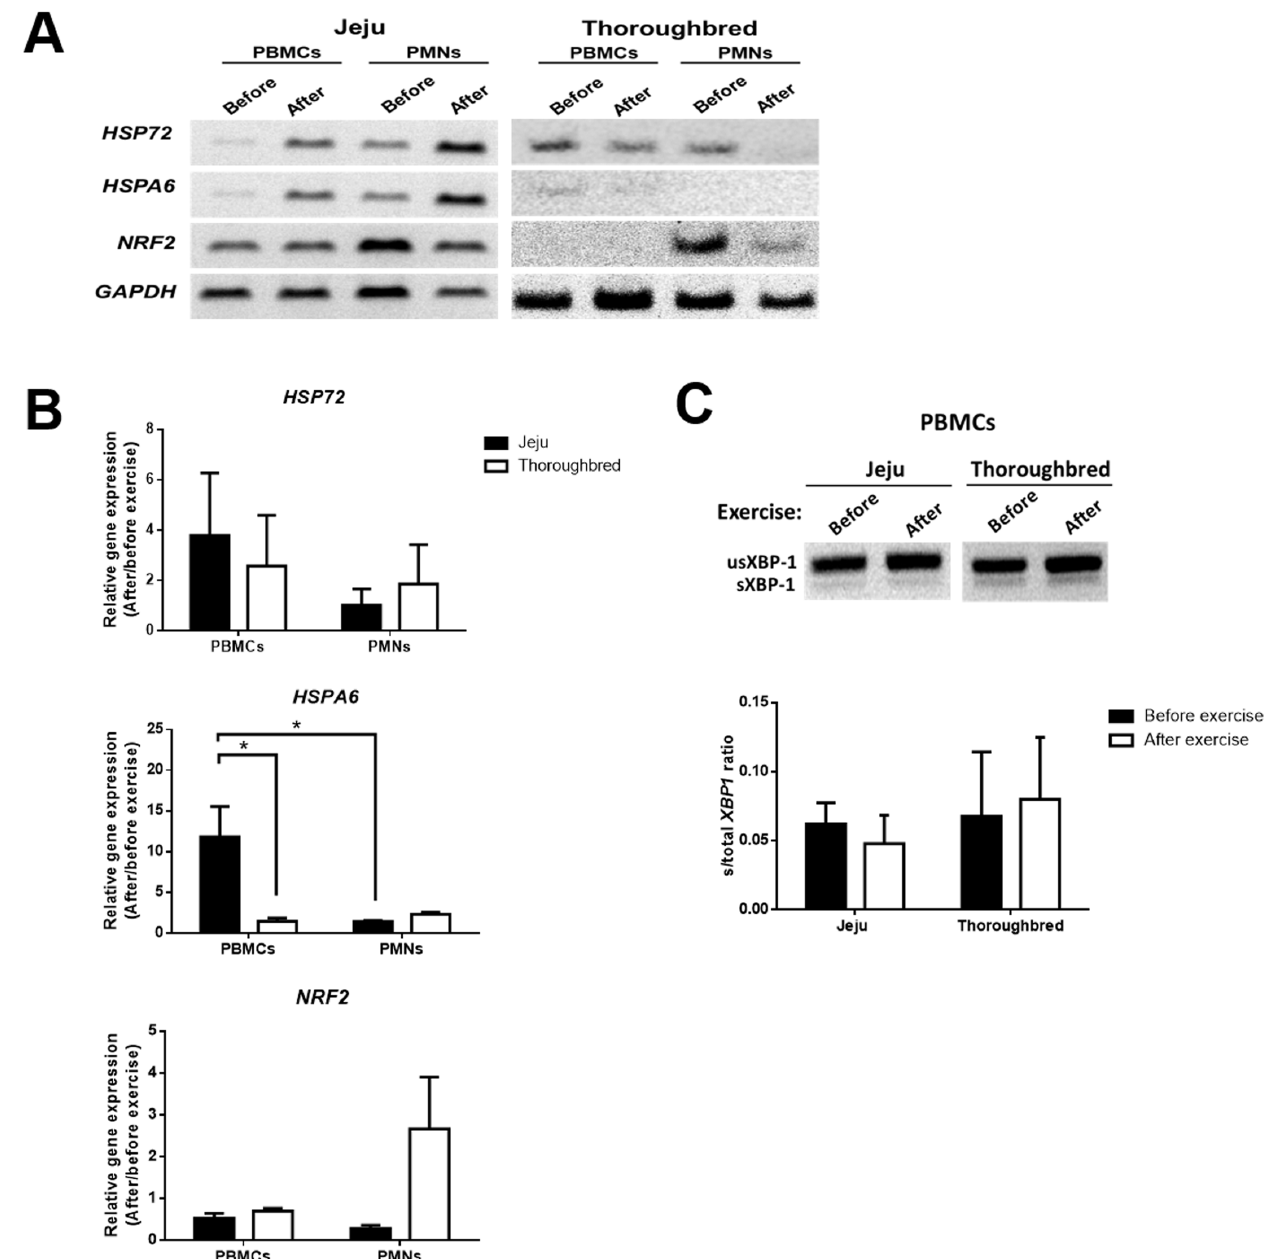
Figure 4. Jeju horses sensitively upregulate the stress-induced gene HSPA6 after exercise. Jeju and Thoroughbred horses were exercised for 30 min. Blood samples were then collected. Peripheral blood mononuclear cells (PBMCs) and peripheral polymorphonuclear cells (PMNs) were separated using Polymorphprep gradient centrifugation. mRNA was extracted from PBMCs and PMNs and reversed to form cDNA to determine the expression of stress-induced genes. (A) RT-PCR of stress-induced genes. Data from one sample from each breed (Jeju and Thoroughbred) is shown. (B) Relative gene expression of stress-induced genes. Black and white bars indicate data from before and after exercise, respectively. Data is represented as means±SEM (n = 3 per breed; * p<0.05, one-way analysis of variance). (C) The expression of unsplicing (us) and splicing (s) XBP-1 was analyzed using RT-PCR and real-time PCR. The relative gene expression of splicing to total XBP-1 was calculated and plotted. Black and white bars represent data from before and after exercise, respectively. Data are represented as means±SEM (n = 3 per breed). RT-PCR, reverse transcriptase polymerase chain reaction; SEM, standard error of the mean; HSP72, heat shock protein 72; HSPA6, heat shock protein family A (Hsp70) member 6; NRF2, nuclear factor erythroid 2 (Nfe2)-related factor 2; XBP-1, X-box binding protein 1; GAPDH, glyceraldehyde 3-phosphate